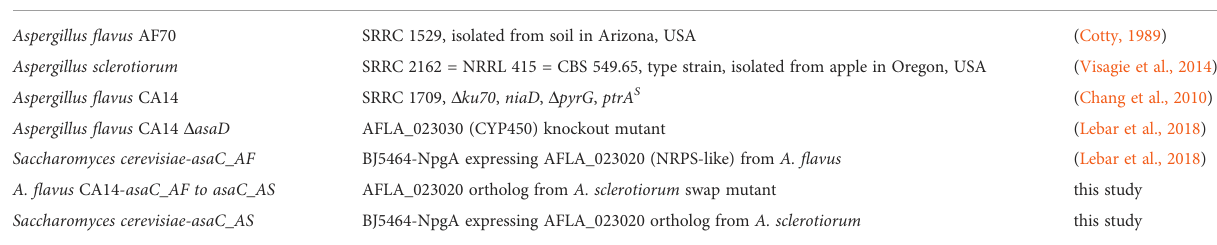
TABLE 1 Strains used in the